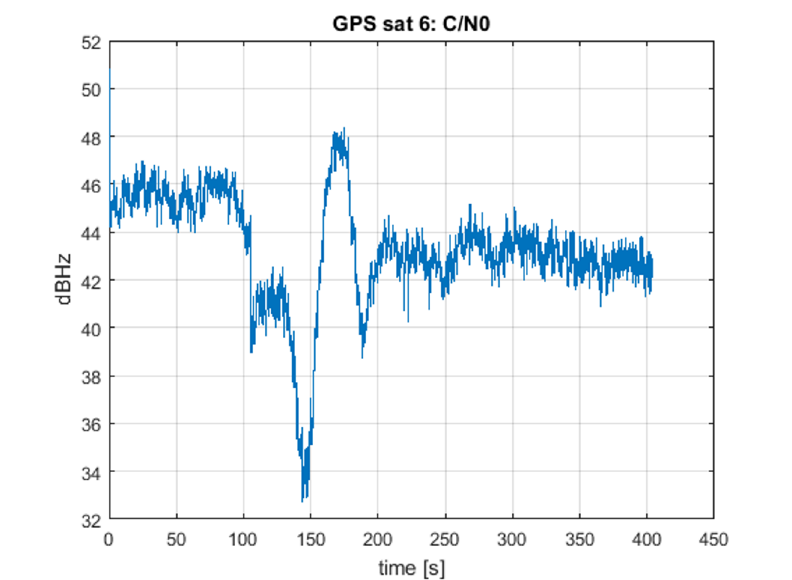
Figure 9. C / N 0 for Satellite 6 using TEXBAT ds3.